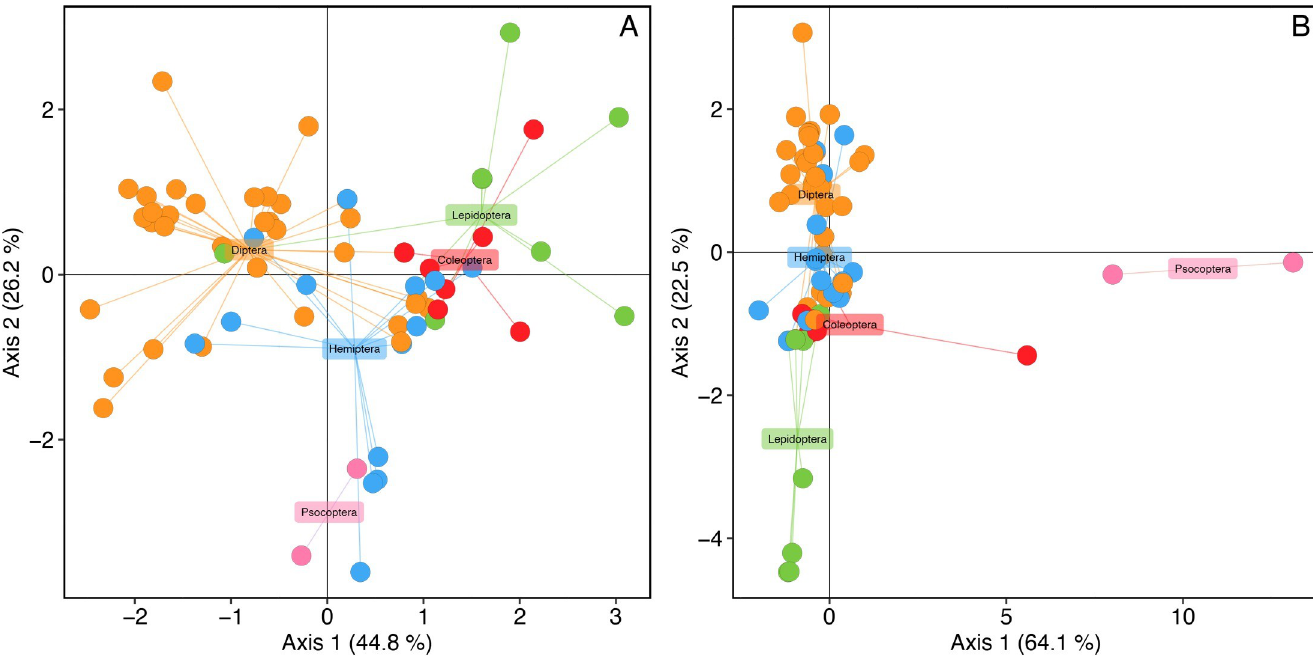
Fig 4. DAPC analysis for the combined ITS1, ITS2, LSU and RPB2 . Data in full ( A ) and clone-corrected ( B ). Specimens are labeled according to host order. Axis 1 explained 44.8% (64.1% for clone-corrected data) and axis 2 explained 26.2% (22.5% for clone-corrected data) of the genetic variation among individuals.